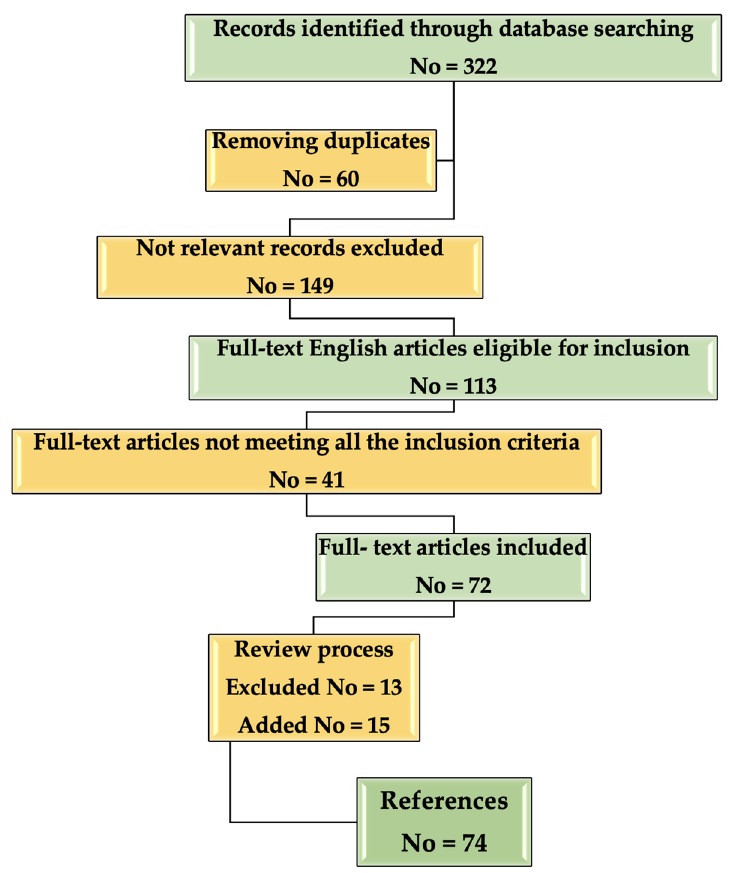
Figure 2. Flow chart describing the selection process of the References included in the study.